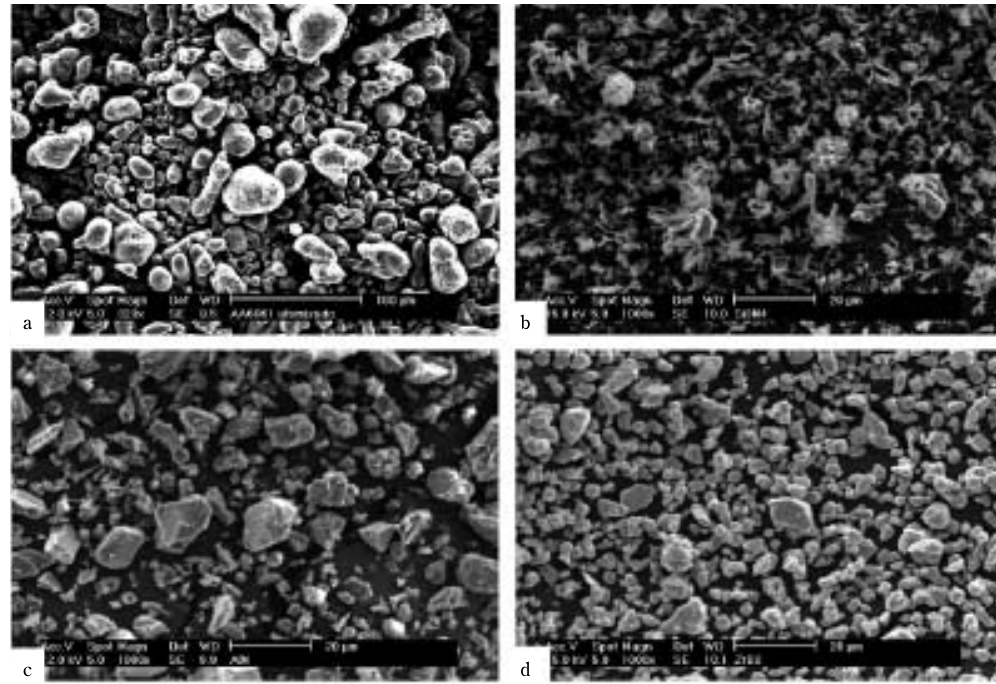
Fig. 1 Raw materials Al6061 aluminium alloy (a), Si 3 N 4 (b), AlN (c) and ZrB 2